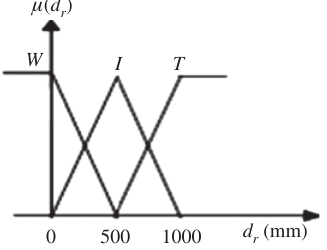
Figure 7: Membership Functions for the Right Distance.